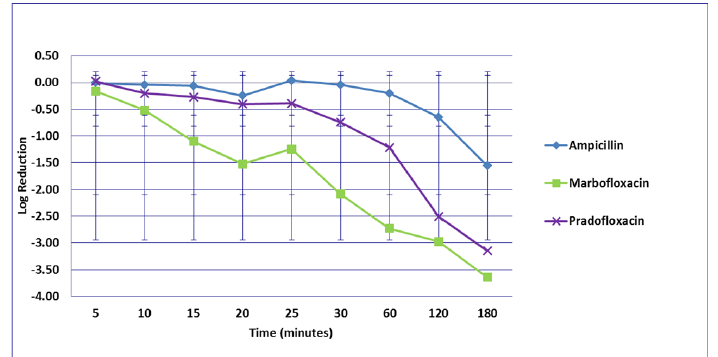
Figure 1. Log 10 reduction in E. coli with bacterial cells exposed to ampicillin, cephalexin, marbofloxacin, pradofloxacin, and trimethoprim/sulfamethoxazole at the minimum inhibitory drug concentration. Data points present mean ± standard deviation.